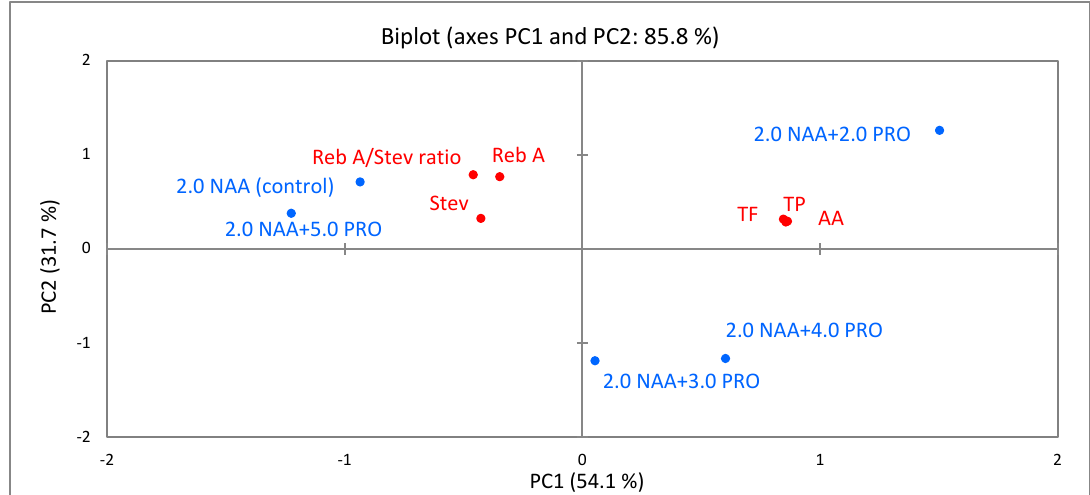
Figure 6. PCA for total phenolics (TP), total flavonoids (TF), stevioside (Stev), rebaudioside A (Reb